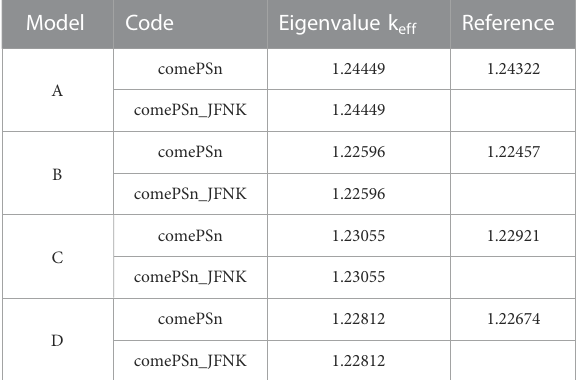
TABLE 4 Results of k-eigenvalues for 2-D full-core MOX/UOX pin-by-pin models A – D.